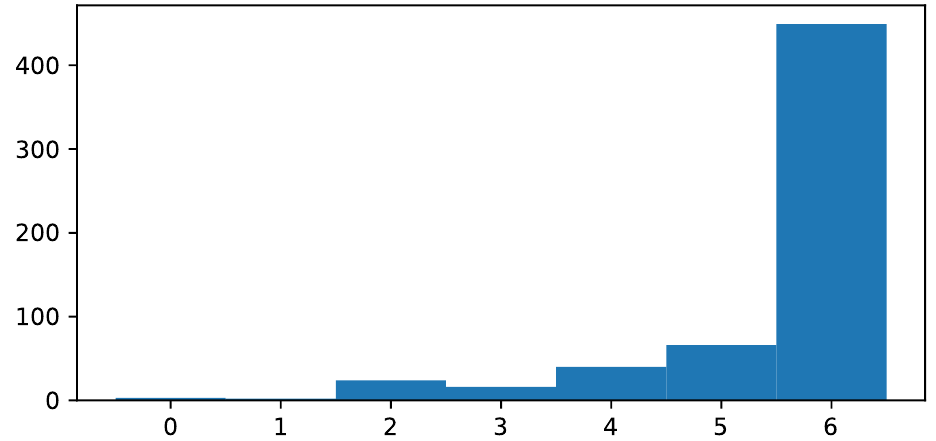
Figure 9. The number of instances from the dataset, for which a specific number of models (listed in Section 3.3) predicted the right